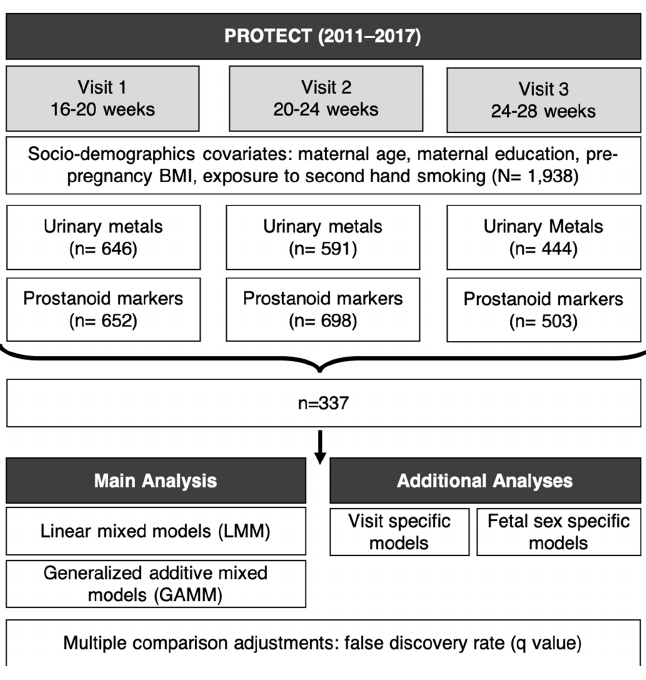
Figure 1 . Schematic plot for PROTECT cohort study design, sample size, and statistical